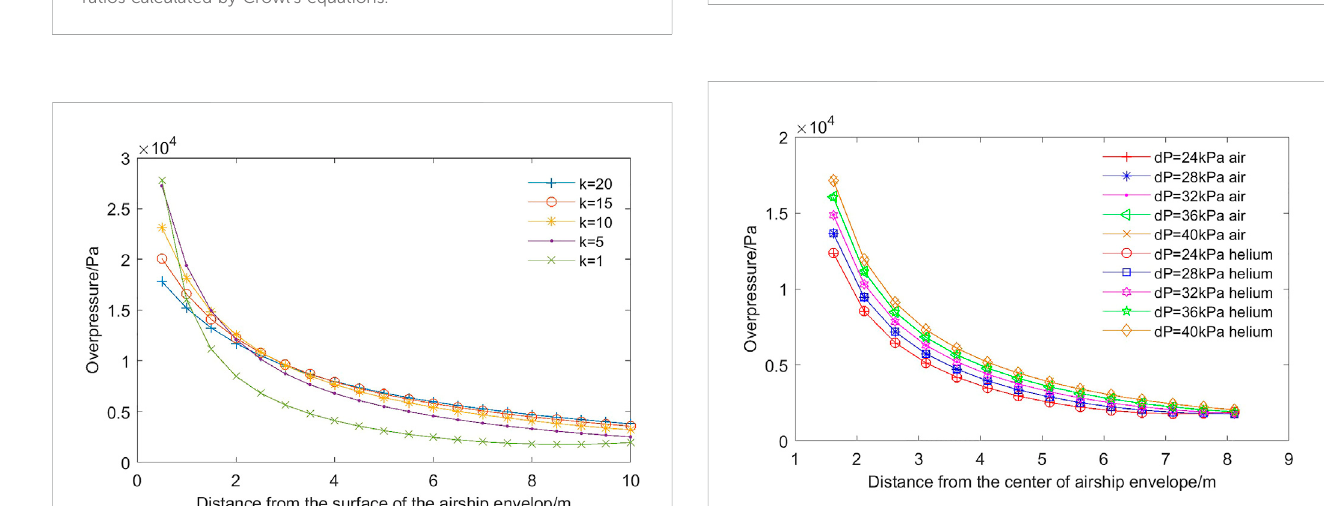
FIGURE 5 Explosion energy for envelopes with different geometric scale ratios calculated by Crowl ’ s equations.